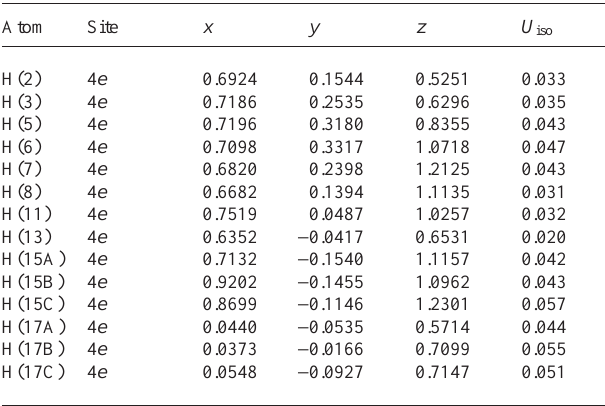
Table 2. Atomic coordinates and displacement parameters (in Å 2 )